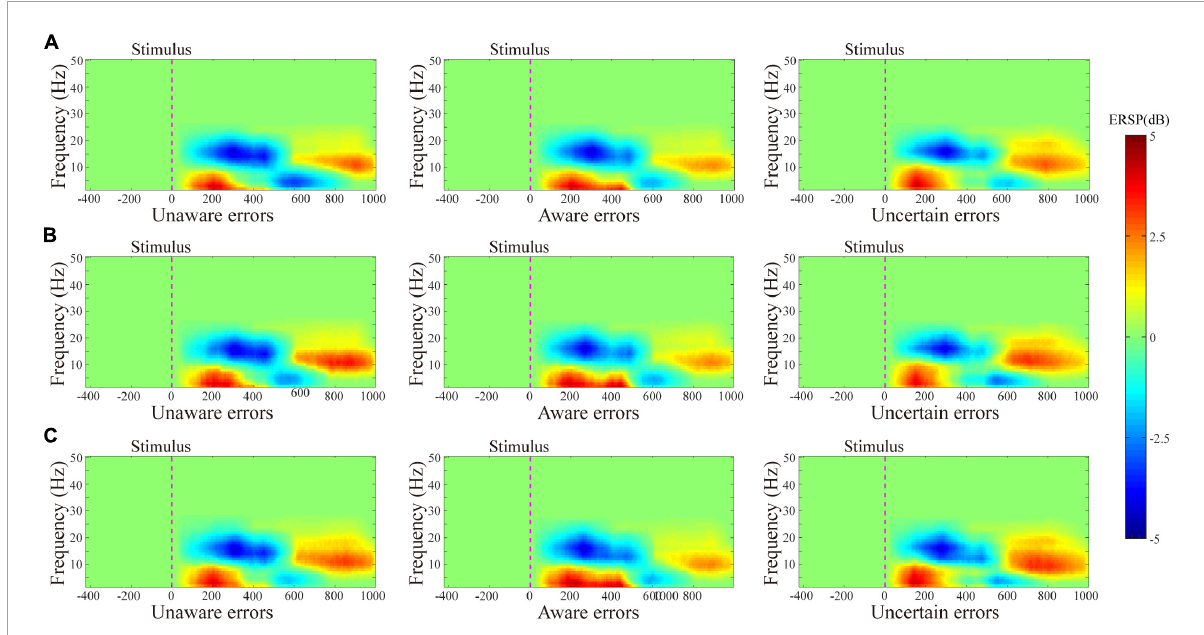
FIGURE2 Results of the average ERSP. ERSP plot with masked unsignificant reactions (green area) shows values averaged for the whole group in each experiment. (A–C) Show the ERSP results from volunteers tested on the ground cabin, pilots tested on the ground cabin, and pilots tested in the flight environment, respectively.